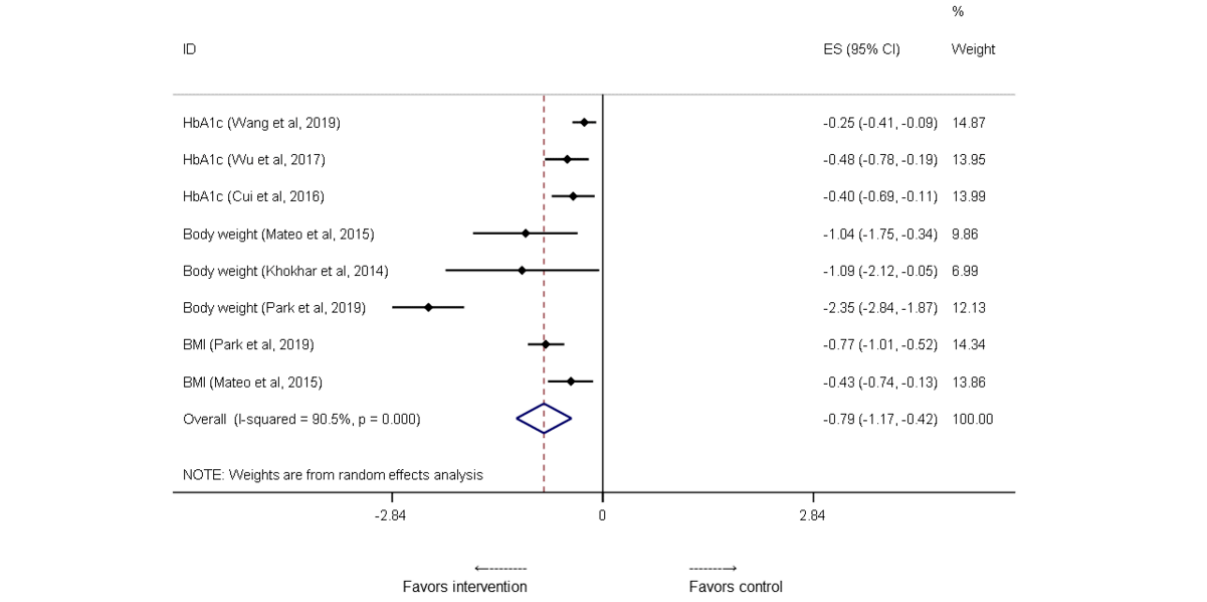
Figure 2. A meta-analysis of mean differences in changes in clinical outcomes after an intervention, mobile health versus control groups. HbA 1c : hemoglobin A 1c